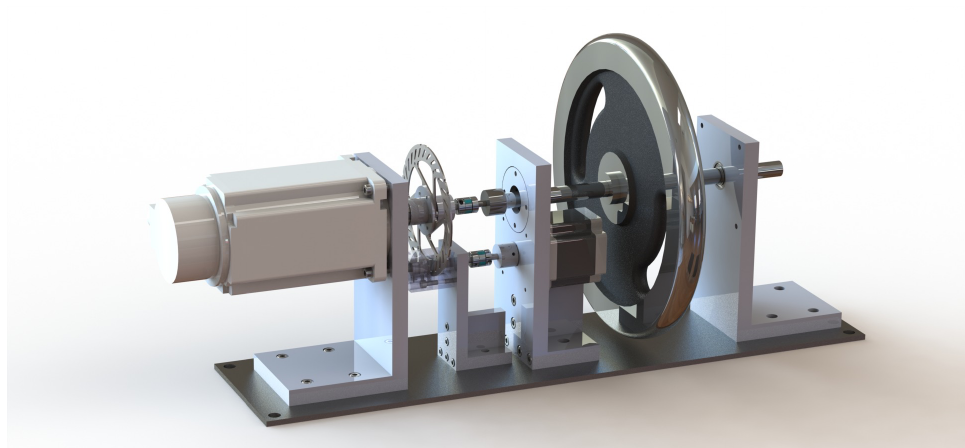
Figure 15. The 3D CAD Model of the test bench.